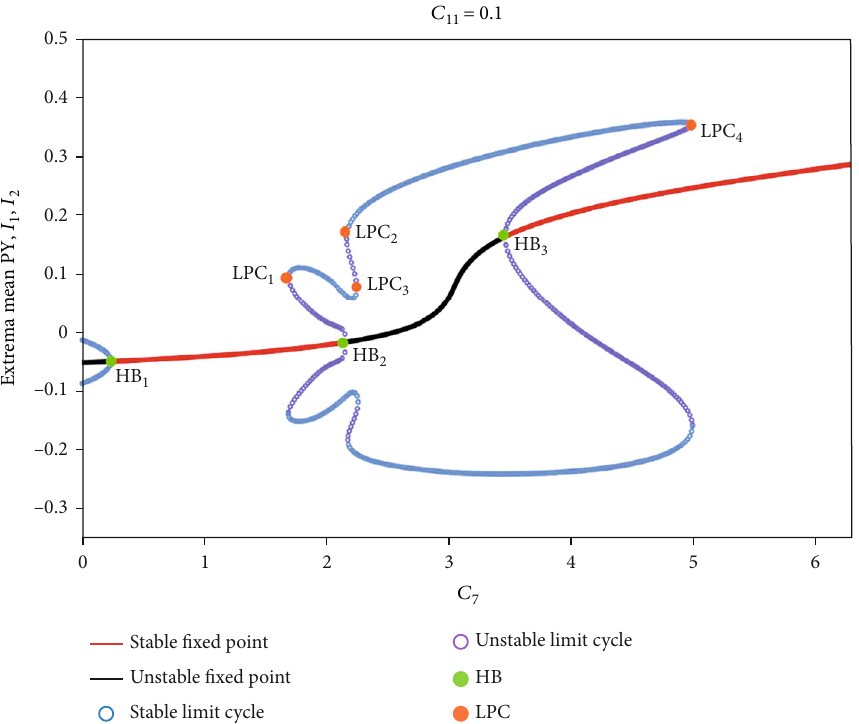
Figure 5: Dynamical analysis corresponding to the state transitions in Figure 2(b). As C supercritical Hopf bifurcation (HB subcritical Hopf bifurcation (HB